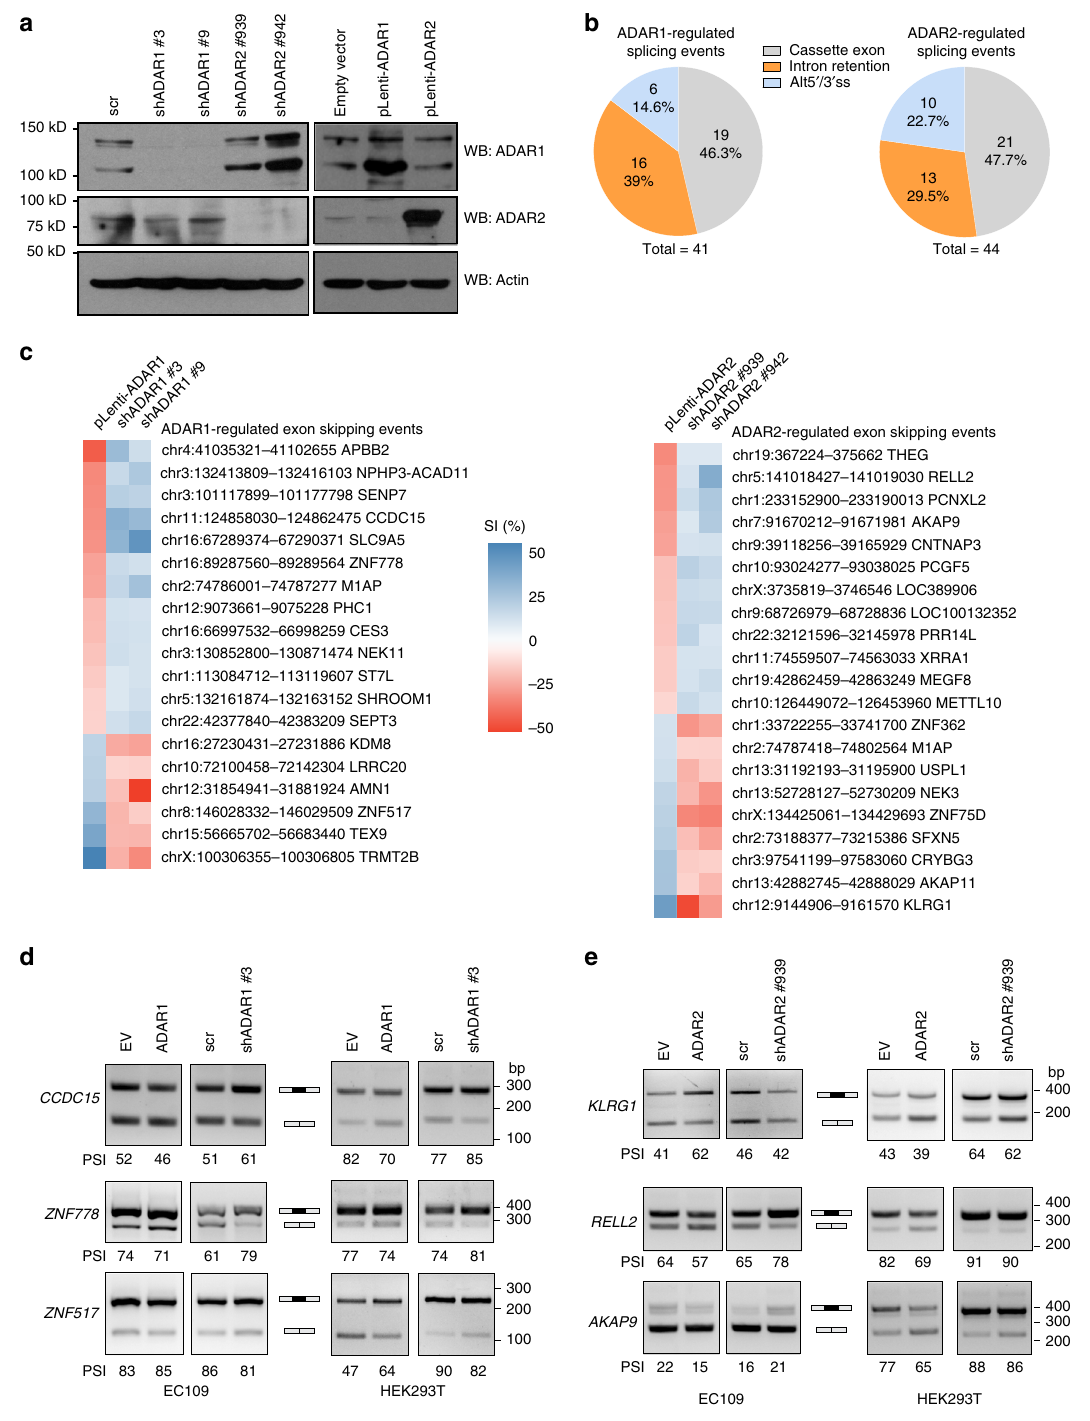
Fig. 1 ADAR proteins regulate a subset of alternative splicing events. a WB analyses of ADAR1 and ADAR2 proteins in EC109 cells that were stably knocked down (sh ADAR1 #3 and #9; sh ADAR2 #939 and #942; and scramble shRNA (scr)) or overexpressed (pLenti- ADAR1 ; pLenti- ADAR2 ; and empty vector control) for ADAR1 or 2, using lentiviral system. β -actin (actin) was used as a loading control. b Pie charts representing the number (and percentage) of each type of alternative splicing events affected by ADAR1 (left) and ADAR2 (right). c Heat maps showing the differentially spliced cassette exon events, upon knockdown and overexpression of ADAR1 (left) and ADAR2 (right). Splicing index (SI) is calculated by the ratio of inclusion junction reads to the sum of inclusion and skipping junction reads, and Δ SI indicates the difference in SI between ADARs knockdown/overexpression and their corresponding control samples. d , e RT-PCR analyses of representative ADAR1- d or ADAR2- e affected cassette exons in original RNA-Seq EC109 cells, as well as HEK293T cells. PSI, percent spliced in. Source data are provided as a Source Data fi